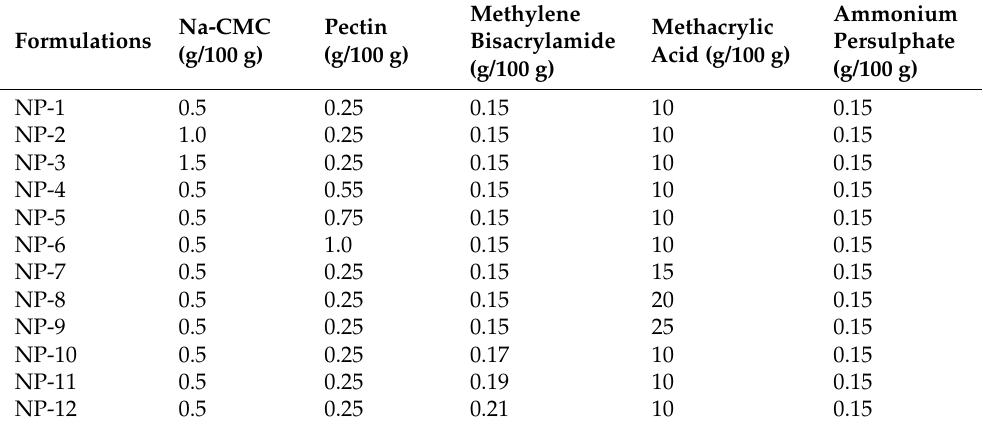
Table 1. Composition of Na - CMC/pectin-g-poly (methacrylic acid) hydrogels (NP-1 to NP-12). Formulations